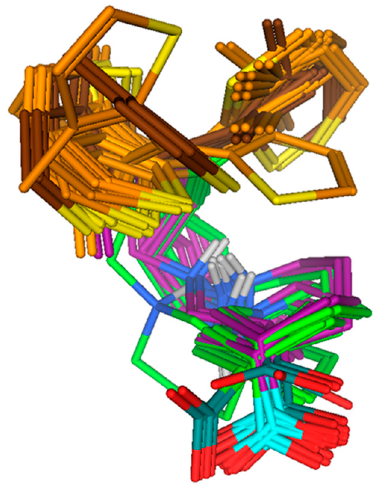
Figure 8. The output of docking protocol I representing conformational overlap of R - and S -enantiomers of tiagabine. Axial and equatorial –COOH groups are highlighted with light and dark cyan, whereas clockwise and anticlockwise orientations of thiophene rings are displayed in light and dark brown. Tiagabine enantiomers with S -configured –NH groups are represented in green, while R -configured groups are in maroon.